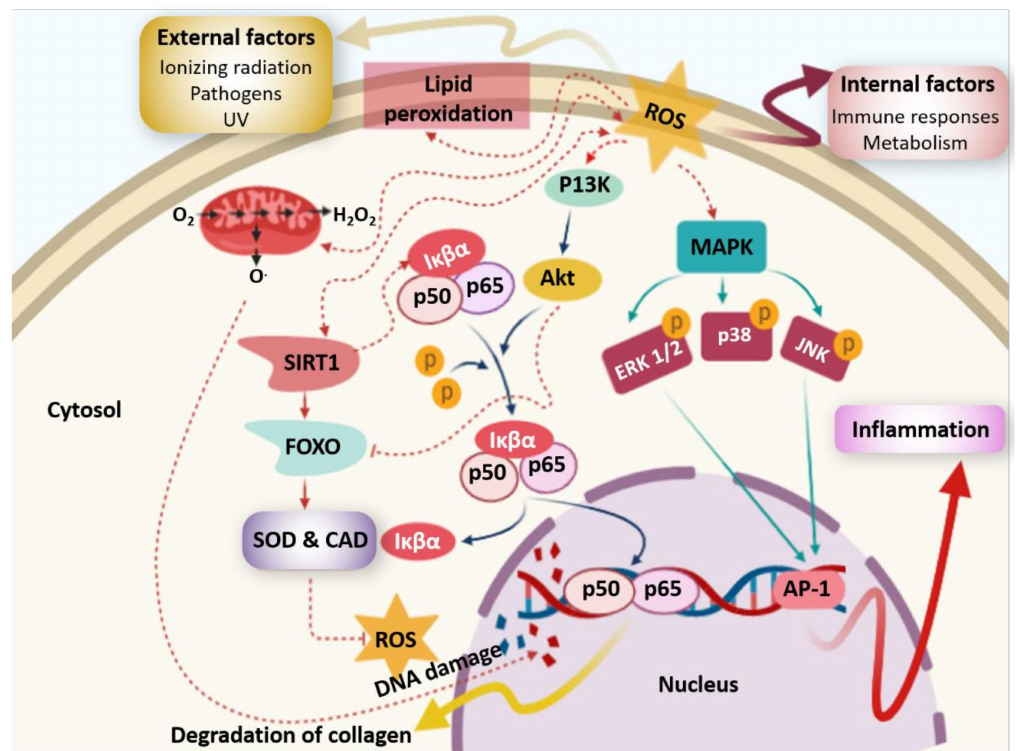
Figure 12. Damage induced by reactive oxygen species